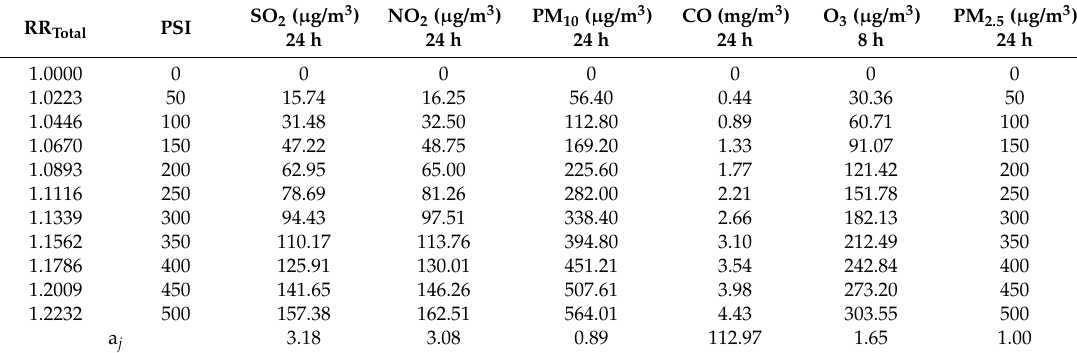
Table 8. The calculated concentrations for the six pollutants at evenly spaced breakpoints of pollutant sub-index (PSI) ranging from 0 to 500, given that PSI = 500 corresponds to the PM 2.5 concentration of 500. a j was calculated according to Equation (7), which was used to calculate daily health AQI (HAQI) with Equation (8).